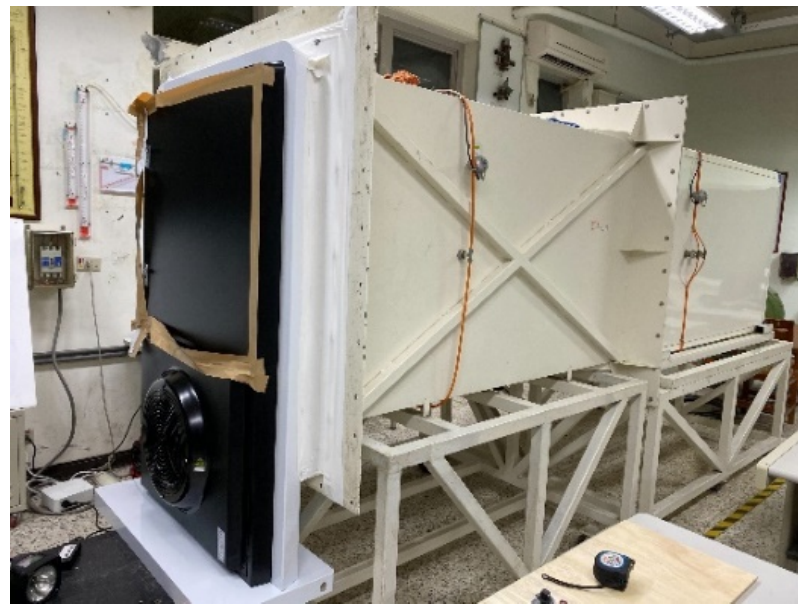
Figure 8. Wind tunnel experiment setup diagram of fan. Table 1. Pressure and air volume of the air purifier at different rotation speeds.